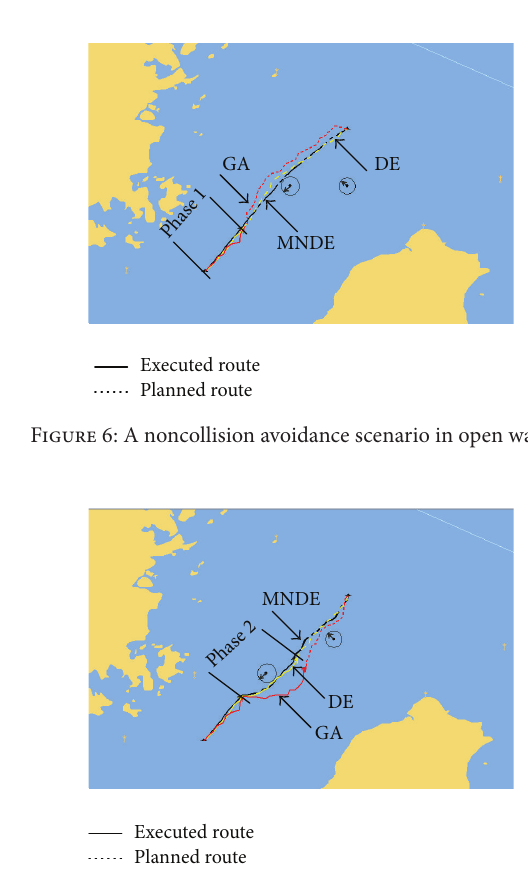
Figure 7: A head-on collision scenario in open